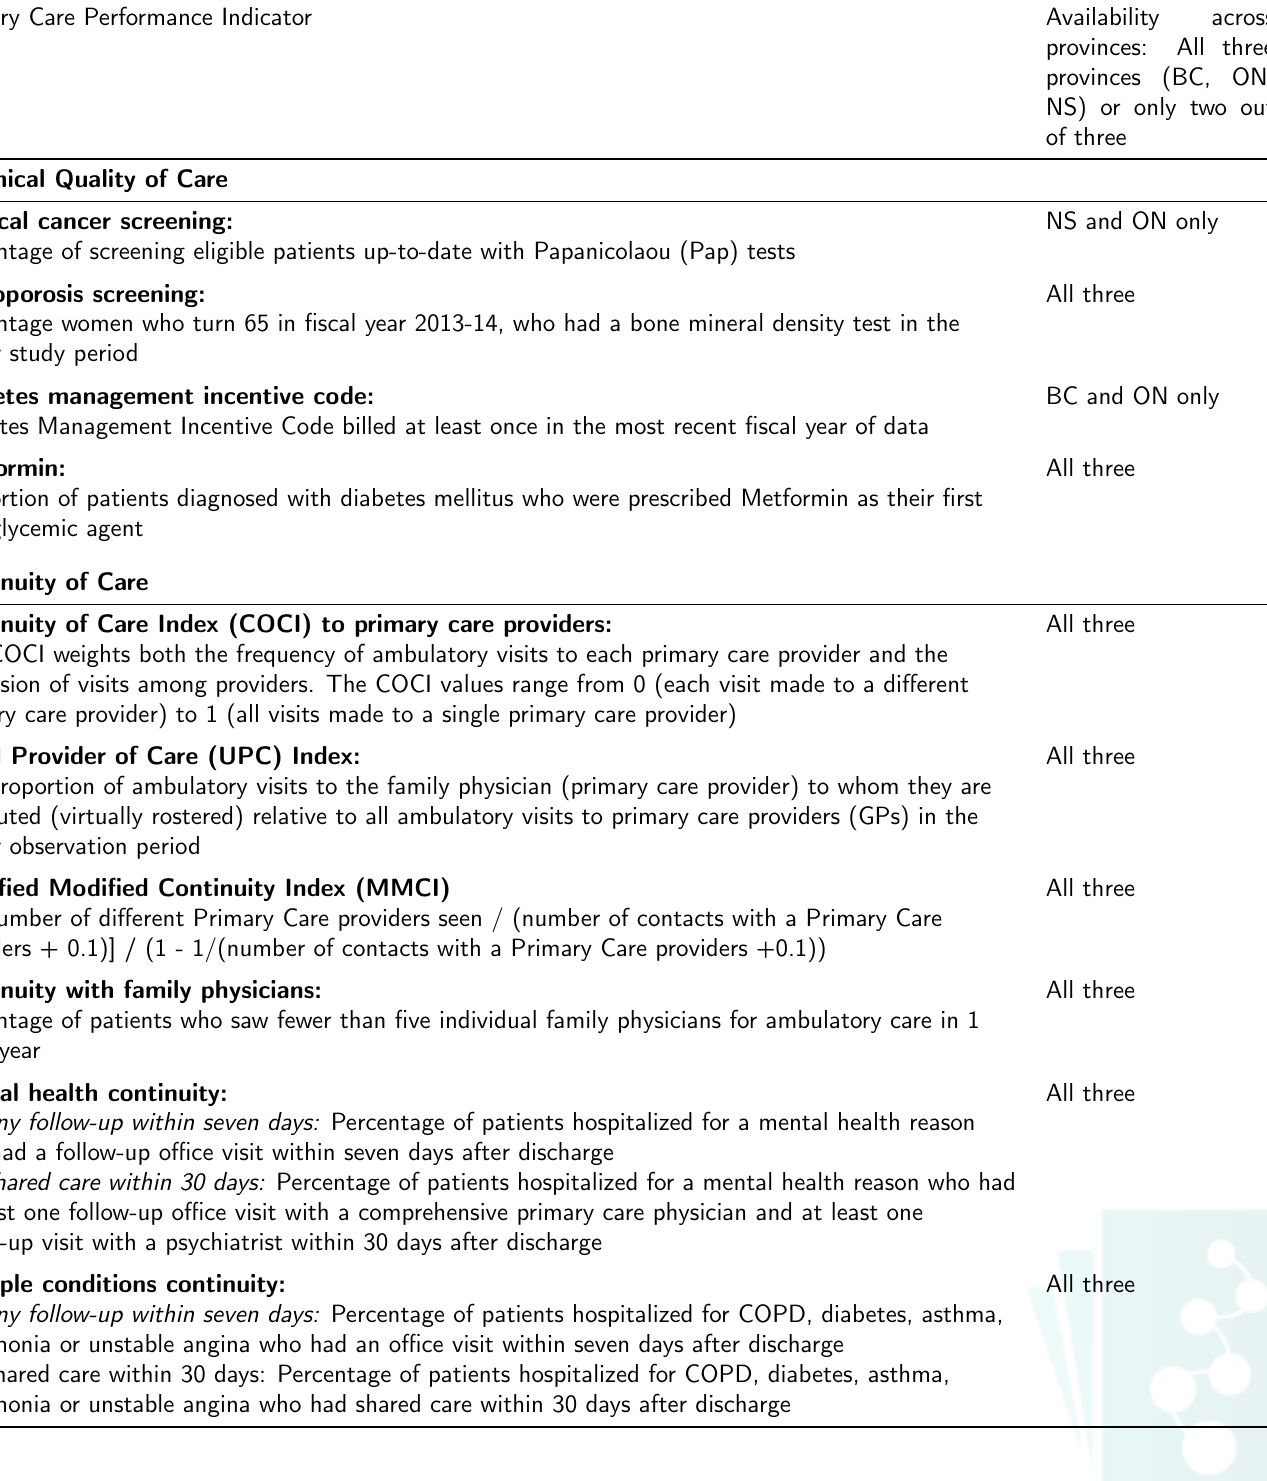
Table 2: Administrative data primary care